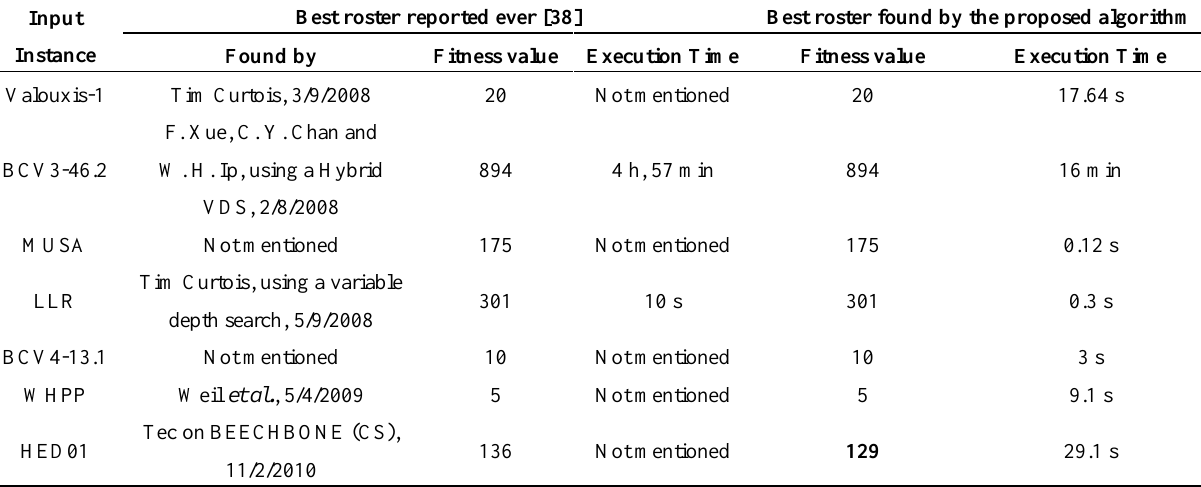
Table 3. Comparing the best timetables constructed by the proposed algorithm with the best timetables ever reported for these specific